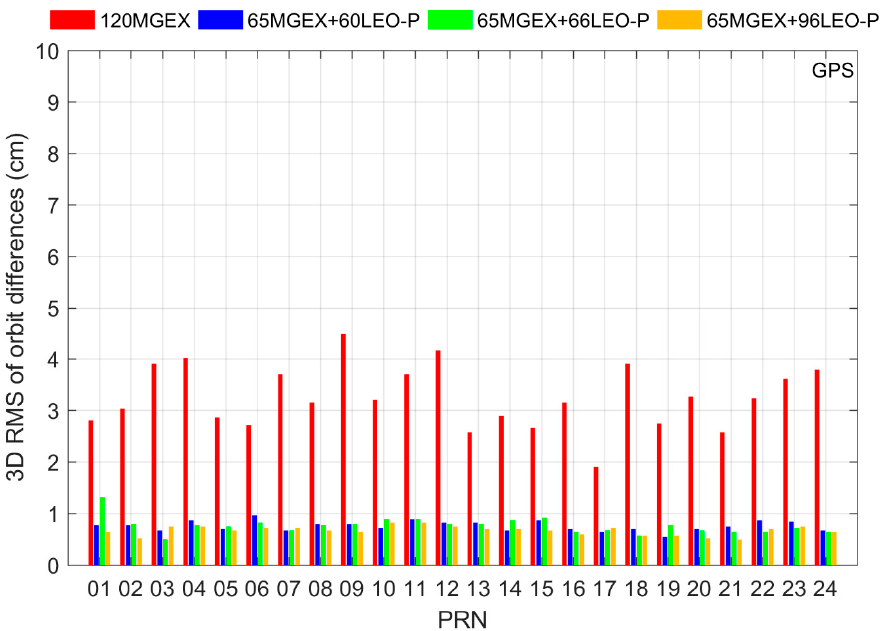
Figure 3. Average 3D RMS values of GPS orbit differences for the integrated POD with different numbers of LEO satellites. P denotes the nearly-polar orbit of the LEO constellation.